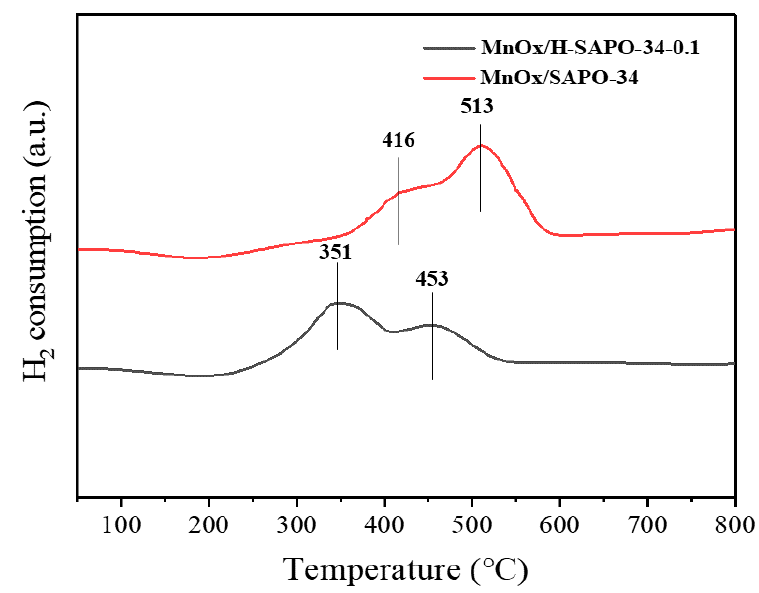
Figure 9. H 2 -TPR profiles of MnO x /SAPO-34 and MnO x /H-SAPO-34-0.1 catalysts.